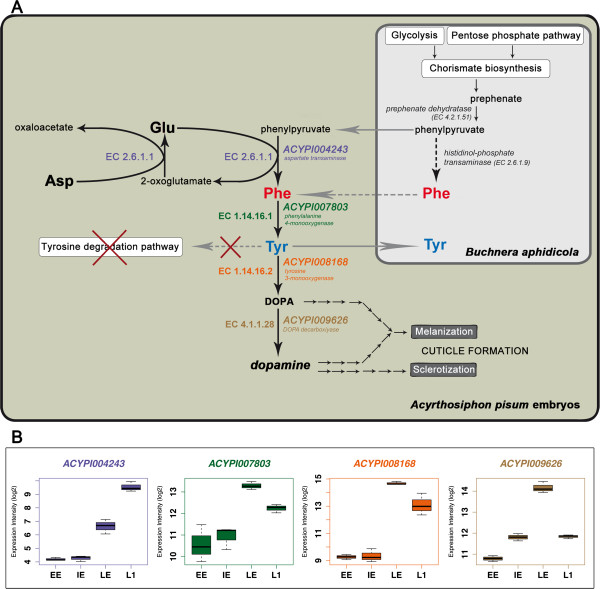
Gene expression regulations acting on the integrated pathway for tyrosine and other precursors of the cuticular tanning biosynthesis in a pea aphid embryo associated with B. aphidicola. A) Schematic representation of the pea aphid embryo (green rectangle) and its symbiotic bacteria (grey rectangle). A summarizing diagram of the Tyr/dopamine pathway during pea aphid development is represented. Black arrows represent reactions, grey arrows transport reactions; solid arrows are annotated events; dotted arrows are possible events; red crosses indicate events not present in the annotation of the genome (see text for details). Only the pea aphid genes whose expression levels change significantly during development are represented. The two B. aphidicola genes did not show significant expression changes during pea aphid development [53]. B) Expression profiles of the genes involved in the Tyr/dopamine pathway in the pea aphid. Expression intensity is given as log2. Expression intensities of each stage are means of the three biological replicates.